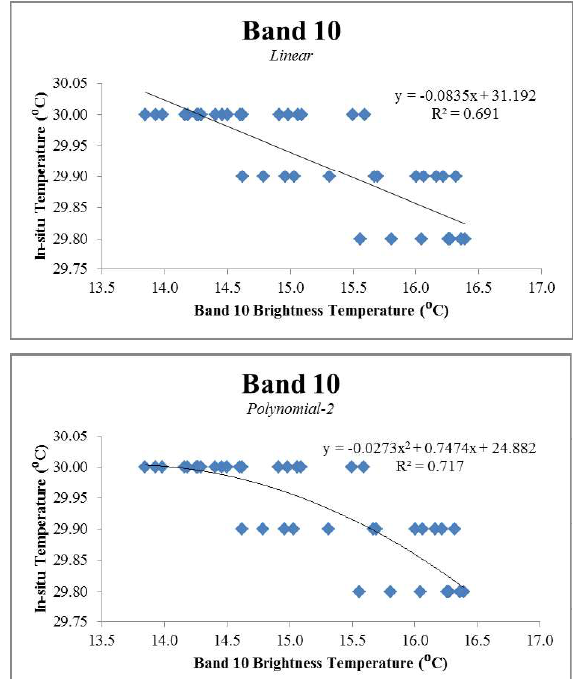
Figure 3. 85 Points for Developing and Validating the Algorithm